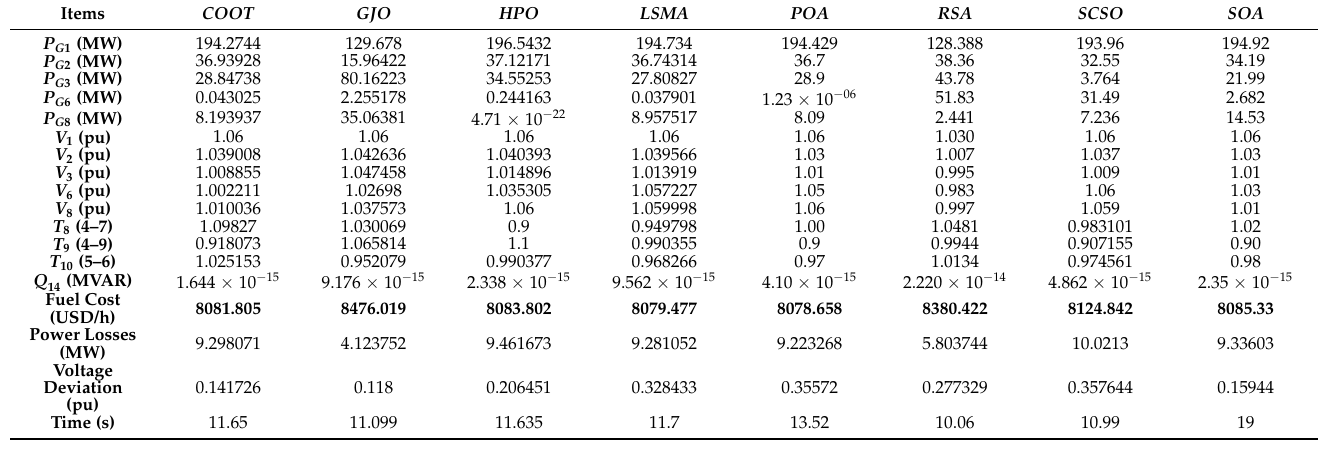
Table 2. Optimal control variables for IEEE 14-bus test system for minimizing fuel cost.